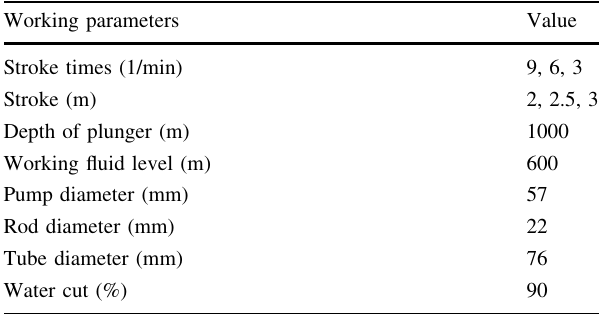
Table 2 Oil well condition and working parameters